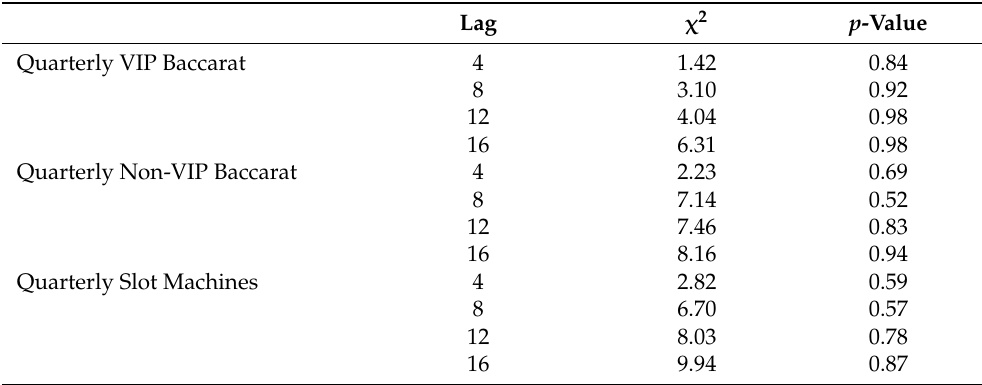
Table 2. Summary of Ljung–Box χ 2 statistics.